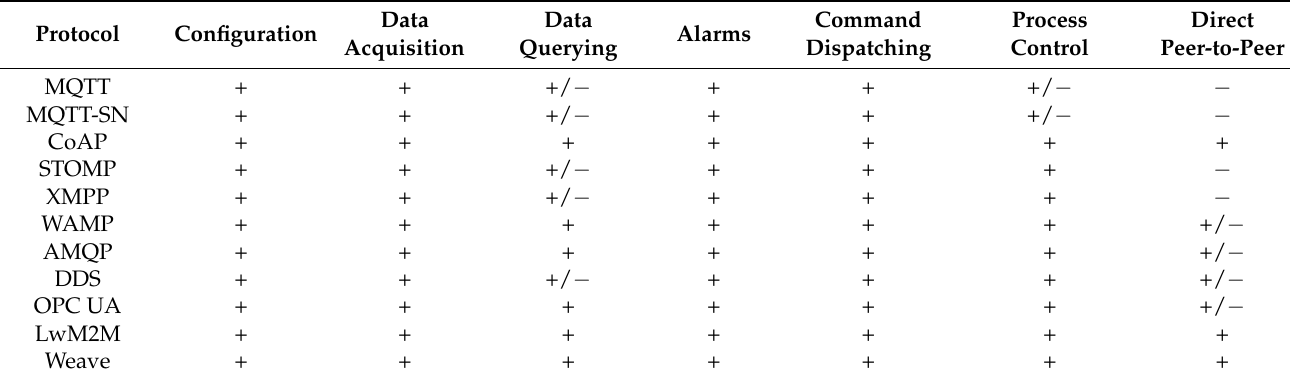
Table 5. Suitability for basic communication